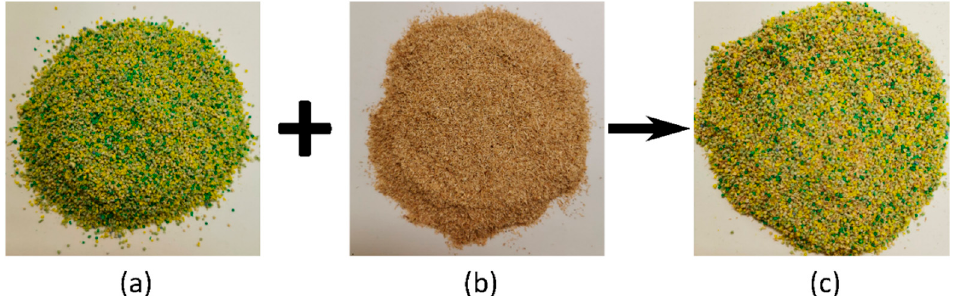
Figure 1. Raw materials used: ( a ) Recycled high density polyethylene, ( b ) maple wood fiber, and ( c ) a dry blend of the materials.